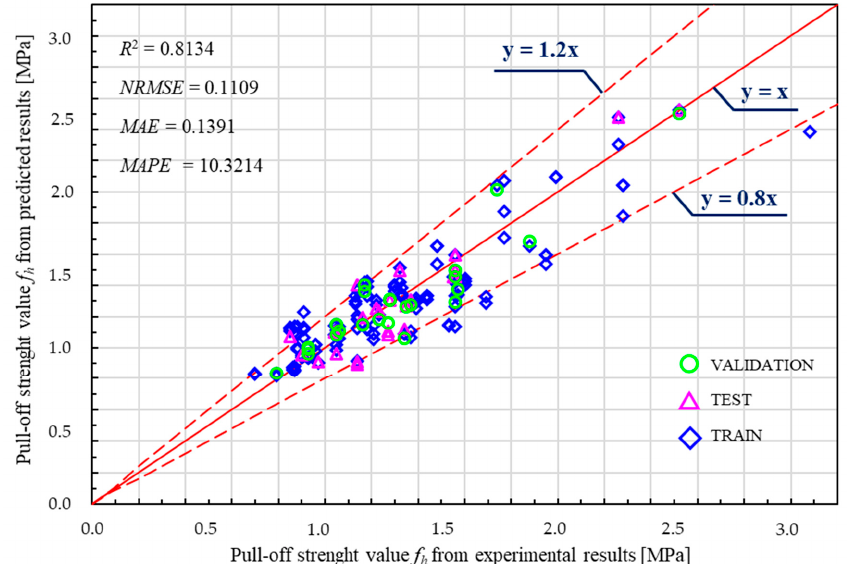
Figure 10. Relationship between the predicted value and the experimental value of the pull-o ff strength f h for ANN test, train, and validation process for the CG algorithm with one layer of hidden neurons.